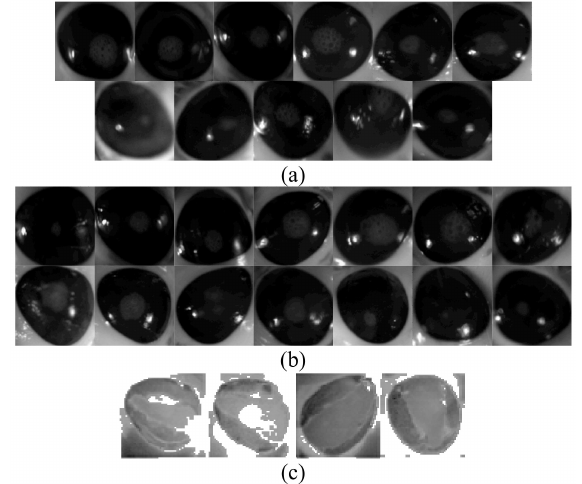
Figure 3. Twenty five hyperspectral images sliced at band-100. All images were normalised and resized to 100 by 100 pixels. ( a ) Rows 1 and 2 are images of healthy corneas; ( b ) Rows 3 and 4 are images of corneas with induced epithelial injuries; ( c ) Row 5 are ground truth